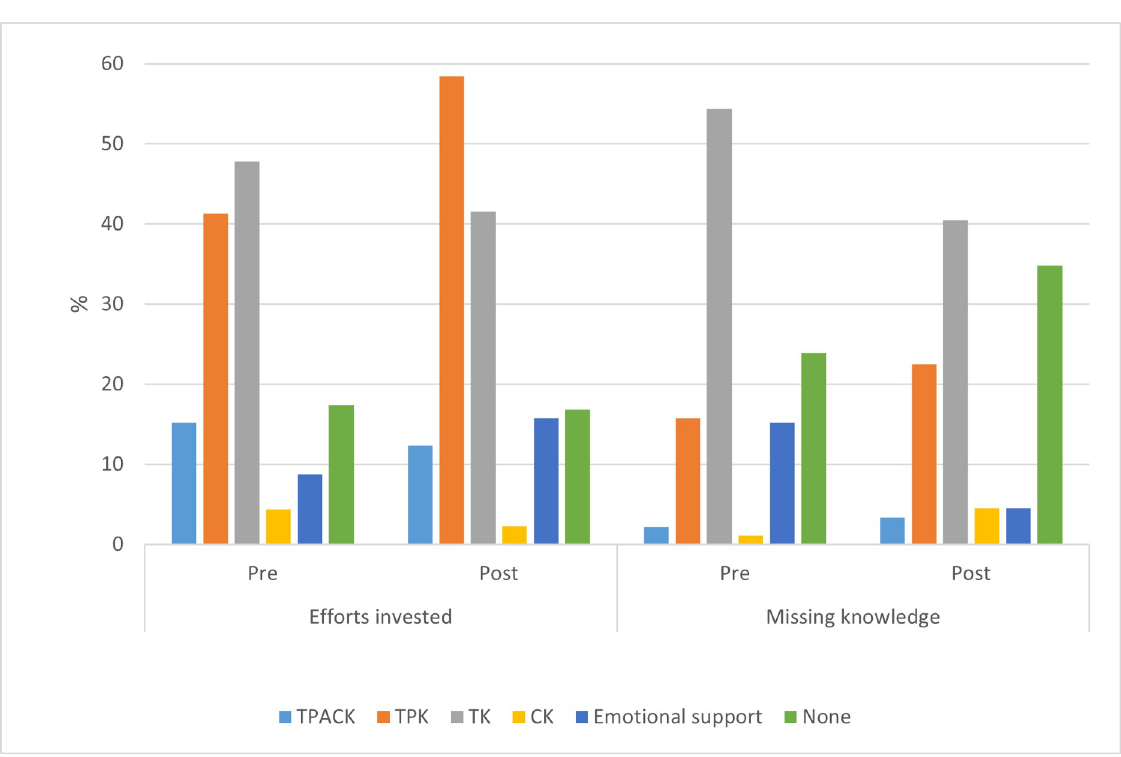
Fig 2. "Missing knowledge" and "Effort invested" in online teaching before and at the end of the semester. Both "Missing knowledge" and "Effort invested" were characterized by TPACK components. The number of participants was used to calculate the percentages for each